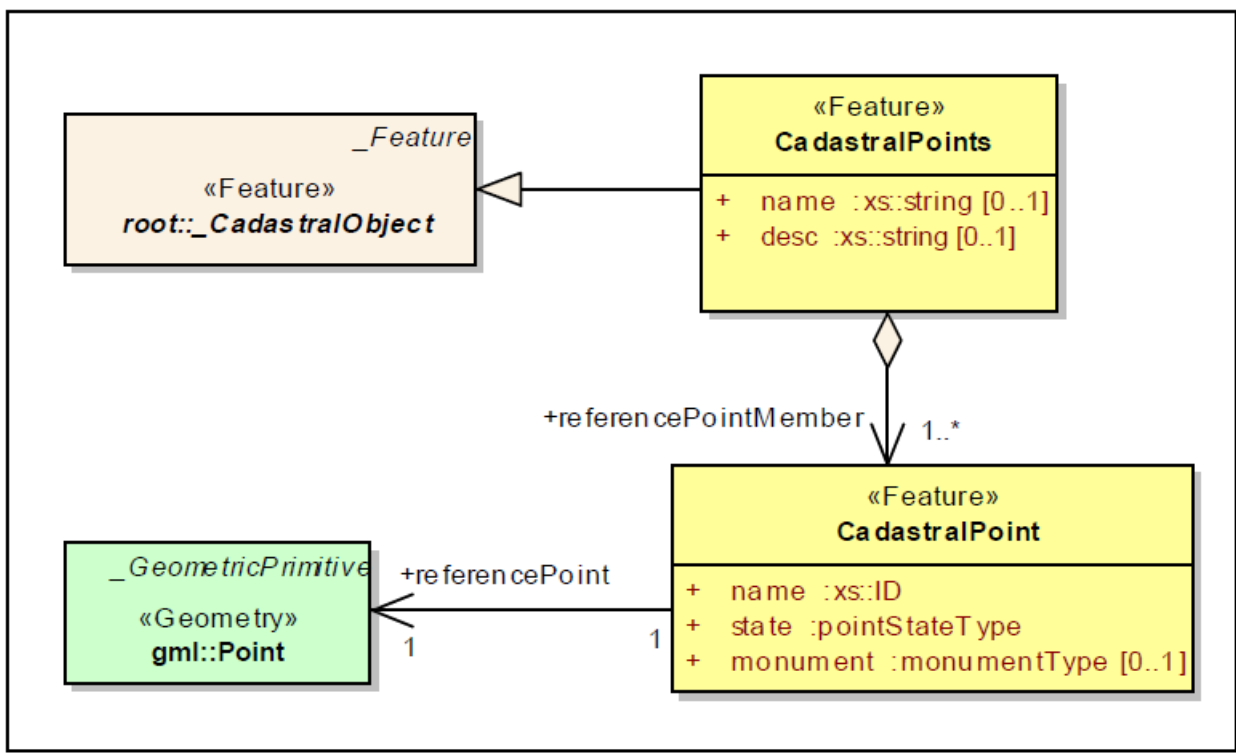
Figure 16. The UML diagram of 3DCDM CadastralPoints